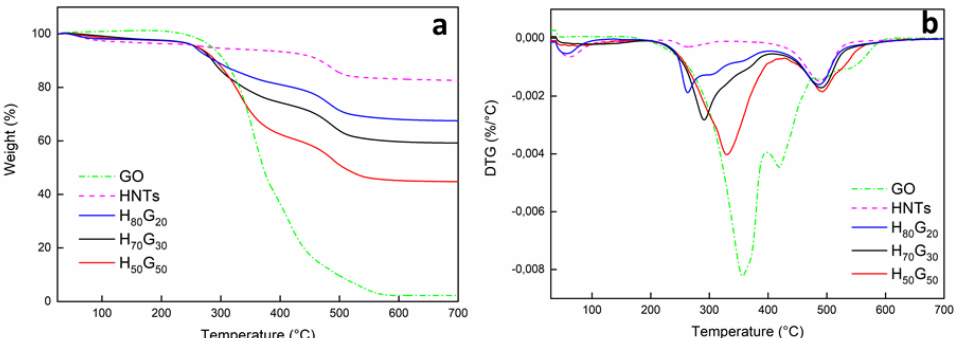
Figure 2. TGA ( a ) and DTG ( b ) curves of HNTs, GO, and